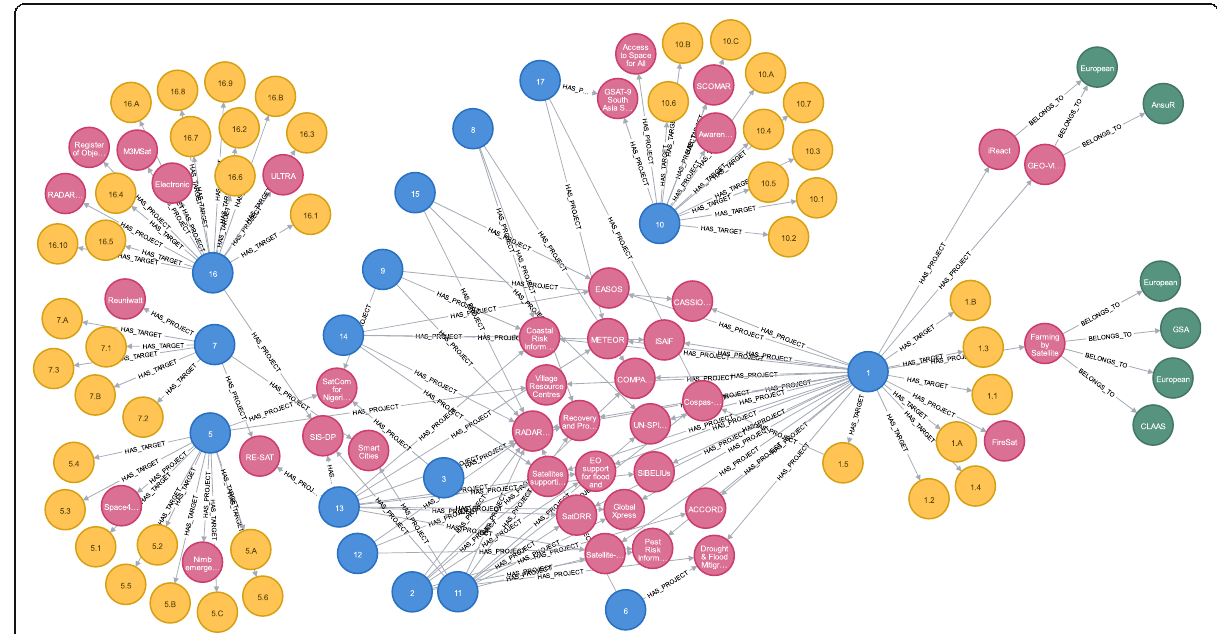
Fig. 2 Extract from the database in pictorial form. The database contains nodes (coloured circles) which are connected by relationships (arrows). Each relationship includes a tag to describe the relationship type (e.g. BELONG_TO), which facilitates more intuitive queries to the database. The nodes are coloured according to their types; in the figure, the colour code is as follows: Green = Institutions; Red = Projects; Blue = SDGs; Yellow = Targets